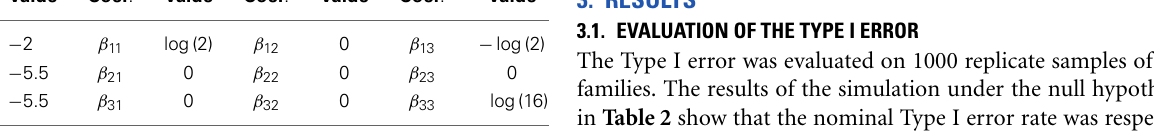
Table 1 | Regression coefficients of the example polytomous model. Coef .